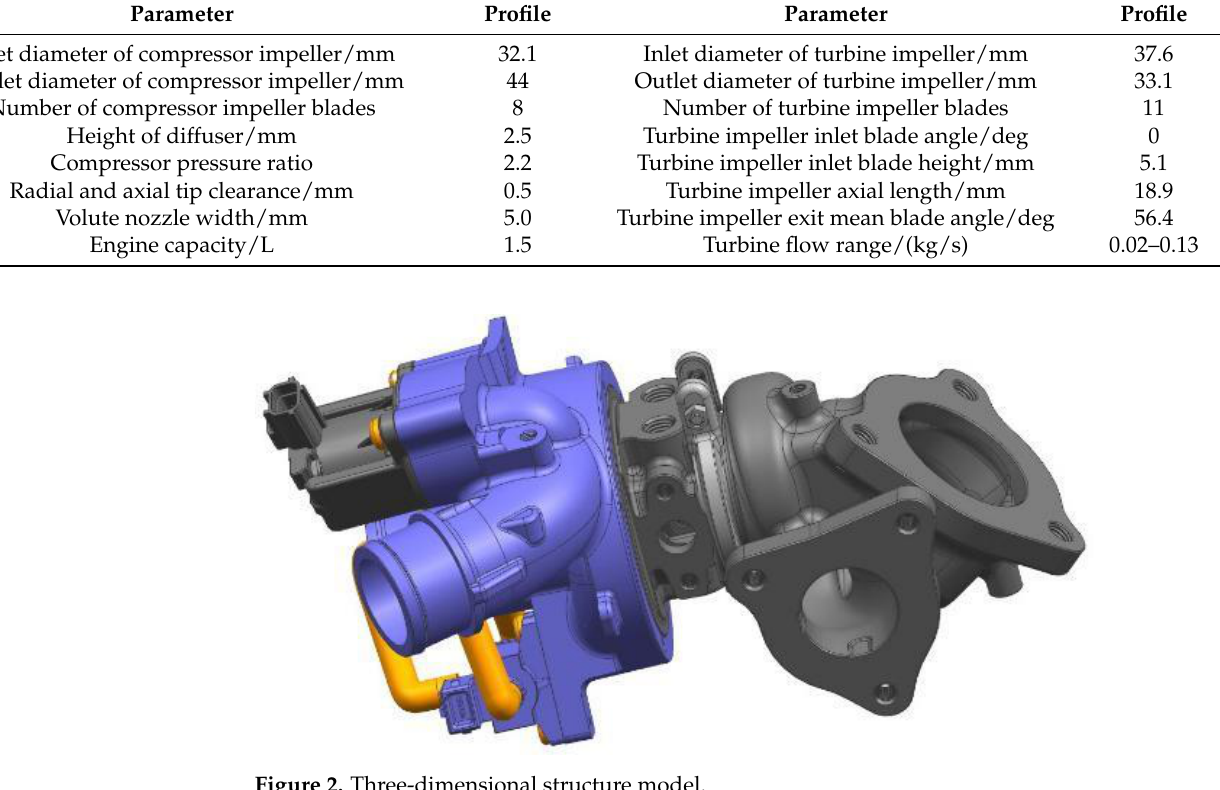
Table 1. Turbocharger parameters.